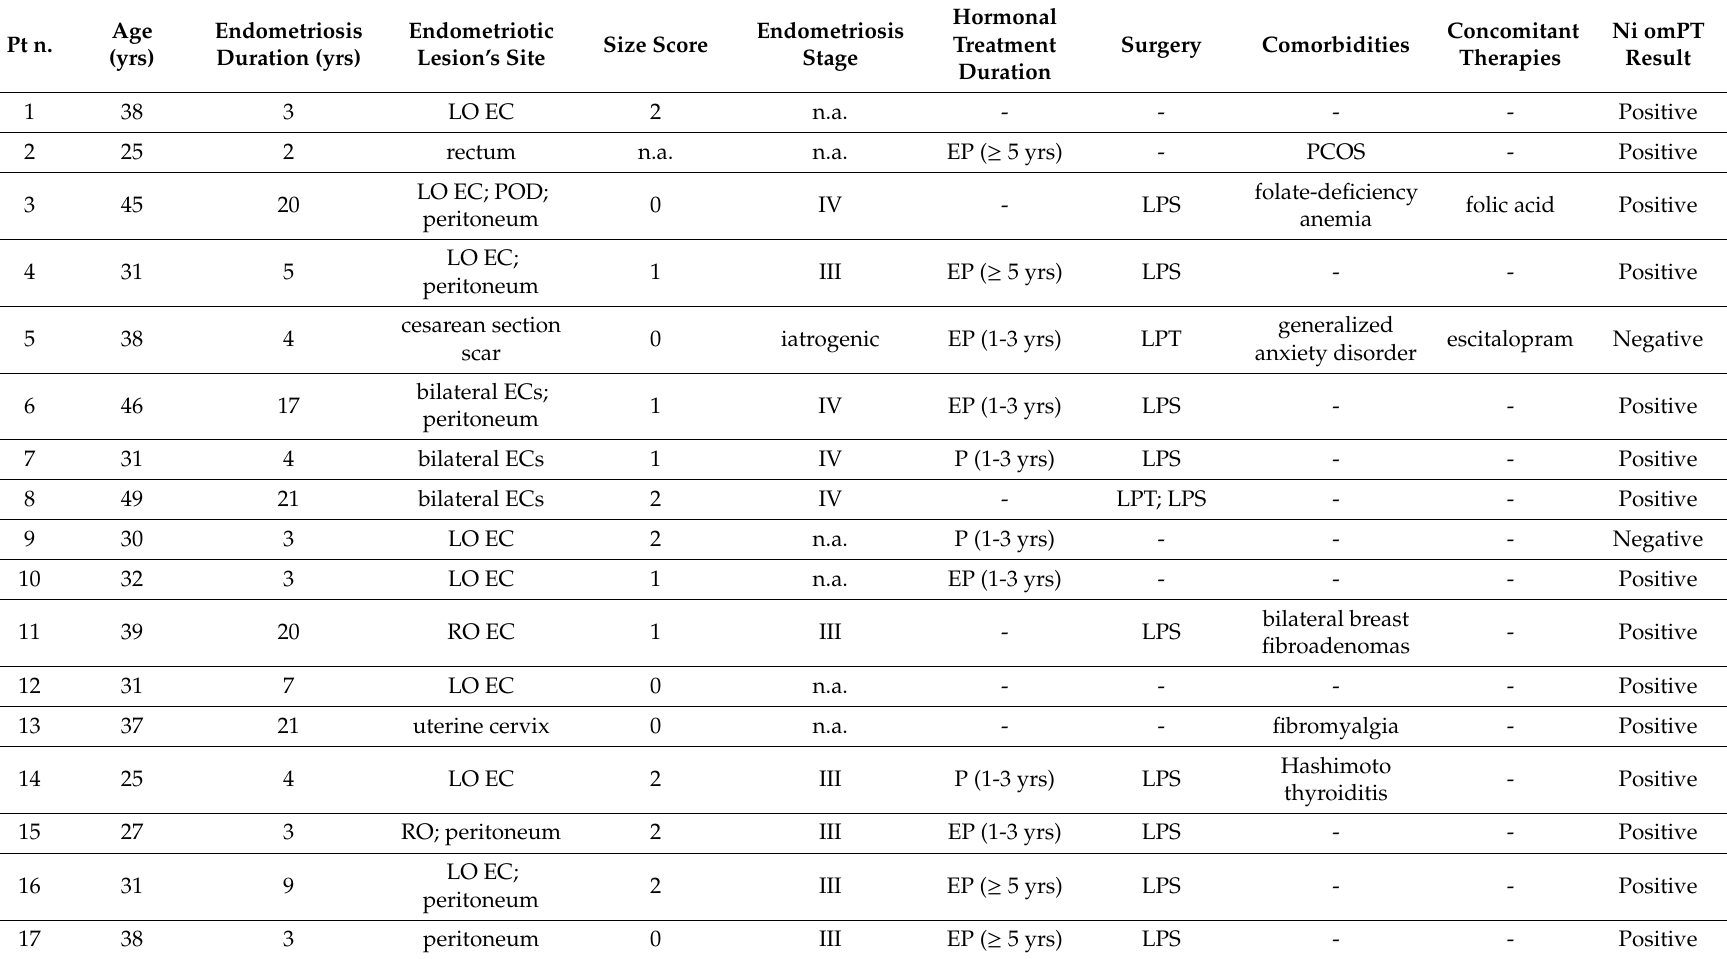
Table 2. Clinical features of the endometriosis patients at the time of recruitment and their Ni omPT results.